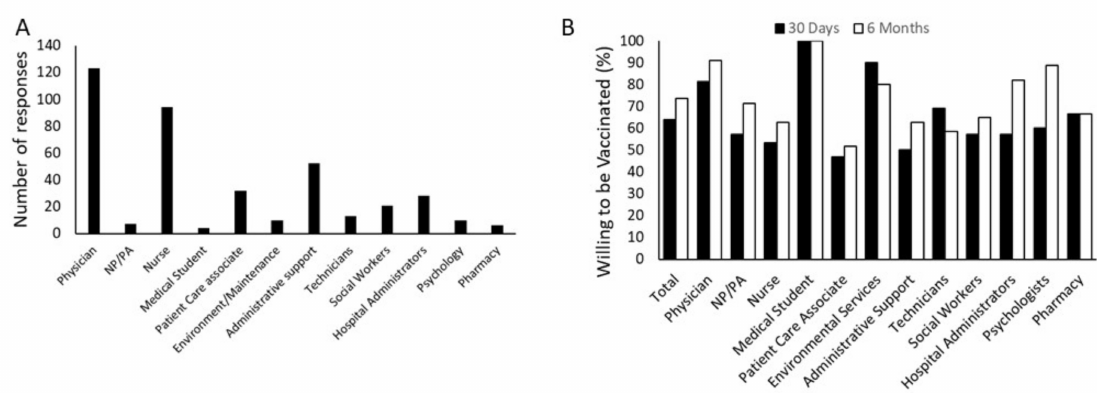
Figure 2. Influence of hospital role on vaccine acceptance. ( A ) Survey responses were unevenly distributed among hospital employees, with an abundance of physicians and nurses. However, multiple roles in all aspects of hospital employment are represented. (NP/PA-Nurse practitioner or Physician’s assistant) ( B ) Willingness to be vaccinated was evaluated by the response to the questions “In the next 30 days . . . ” or “In the next 6 months . . . ” with responses being “I plan to vaccinate myself” or “I will not vaccinate myself.” The respondent’s role in the hospital significantly affects their plan to be vaccinated within both 30 days ( χ 2 = 35.69, p < 0.001) and six months ( χ 2 = 40.22, p < 0.001) N = 426.